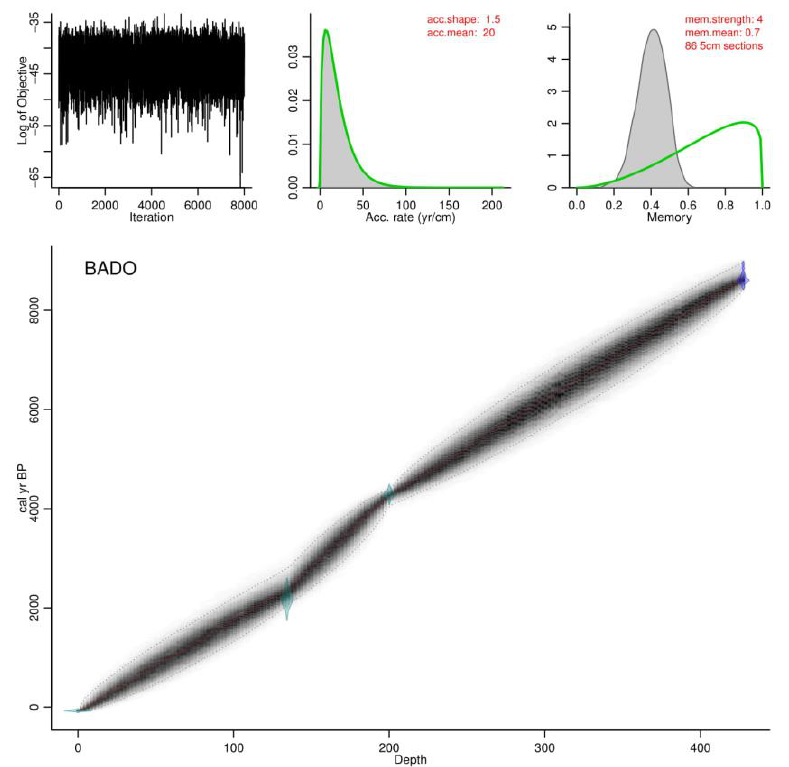
Figure A3b. Age-depth model produced in BACON for